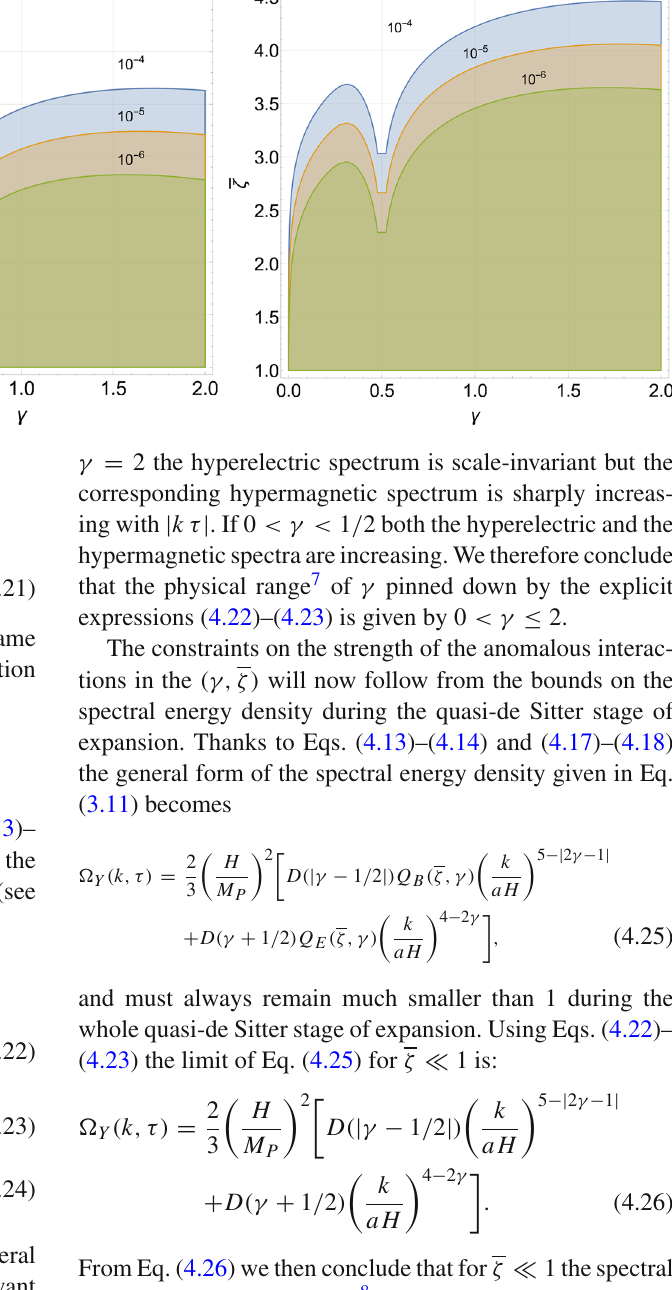
Fig. 1 The critical density bounds during the quasi-de Sitter stage of expansion are illustrated in the (γ, ζ) plane. The difference between the left and right plots comes from a different value of the tensor to scalar ratio r T entering the estimate of ( H / M P